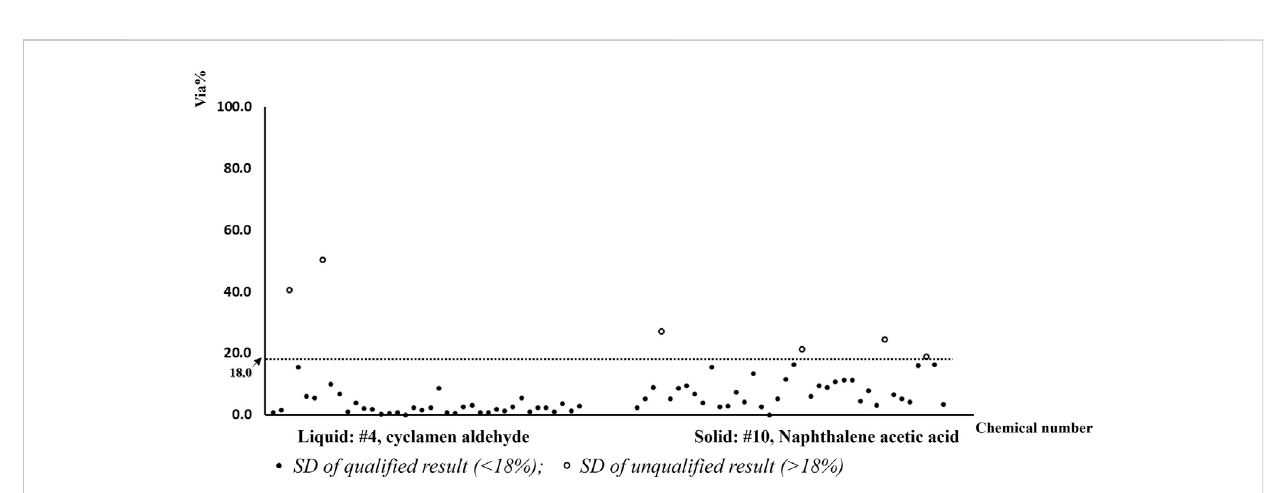
FIGURE 8 SD of cell viability for chemicals considering 38 quali fi ed runs of test in the fast-learning classes.